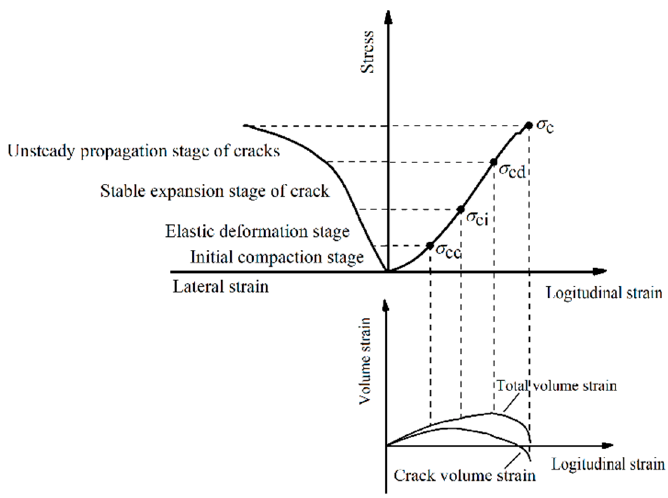
Figure 8. Division of damage evolution stages of the rock.